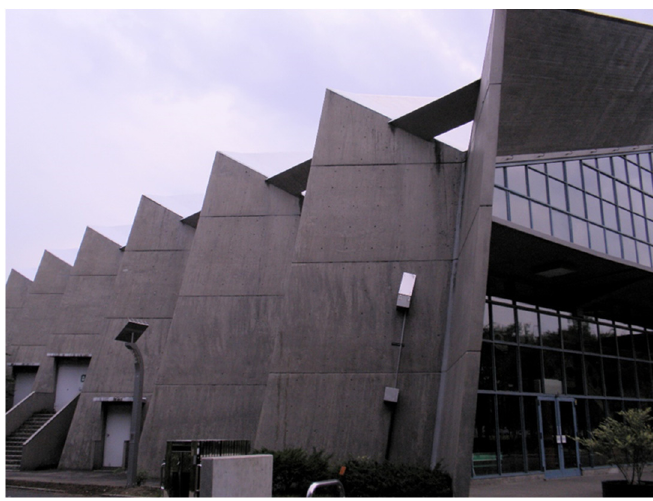
Figure 18. Folded V-shaped concrete sheets in the Performing Arts Center in Gunma, Japan.